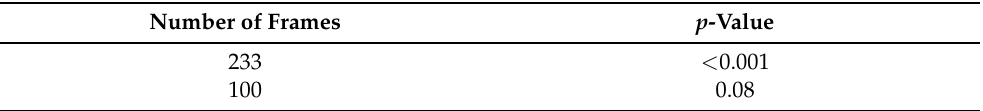
Table 1. ANOVA p -values between NED and frames; 233 frames show a correlation between the two parameters. Vice versa, 100 frames show no correlation.